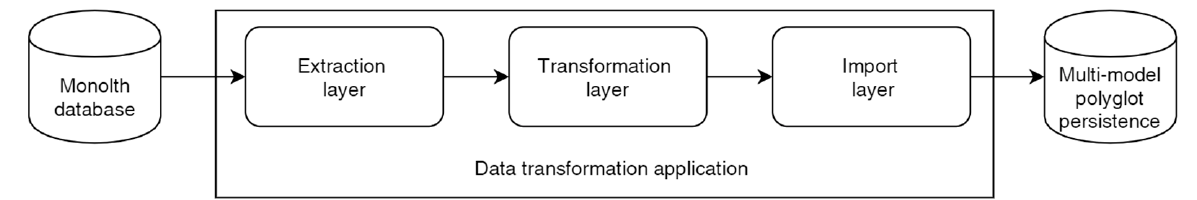
Figure 20. The data transformation from the monolith database to multi-model polyglot persis- tence.